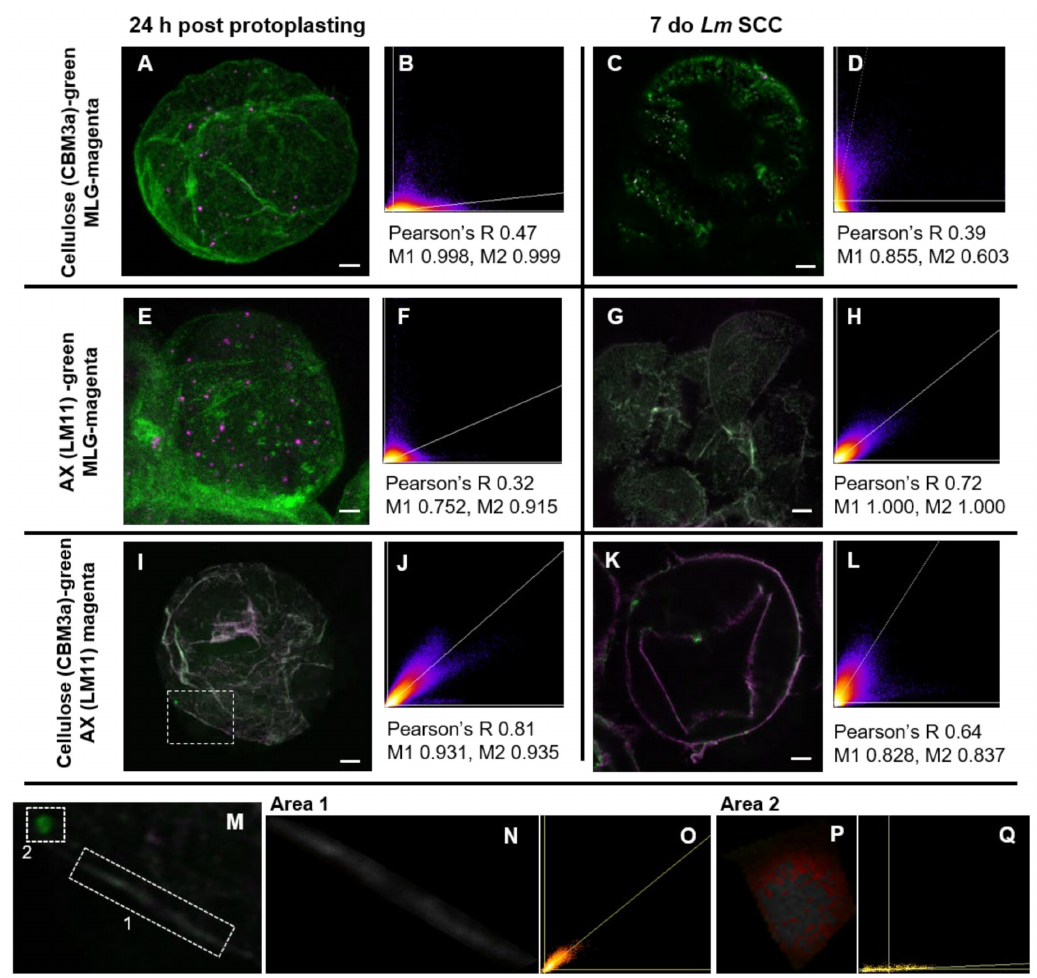
Figure 6. Colocalization of polysaccharides in Lolium SCC cells at 24 h post-protoplasting ( A , B , E , F , I , J ) and of 7 do cells from culture ( C , D , G , H , K , L ). Representative images showing colocalization in white/gray ( A , C , E , G , I , J ) alongside Pearson’s correlation coefficient graphs ( B , D , F , H , J , L ), Pearson’s coefficients, and Manders (M1 and M2) values. Colocalization was not observed between MLG and CBM3a at both time points ( A – D ). For MLG and LM11 at 24 h post-protoplasting ( E , F ), no colocalization was apparent, but there appeared to be colocalization in 7 do SCC. Colocalization was apparent between CBM3a and LM11, possibly decreasing in mature cell walls, indicating that crystalline cellulose and AX are closely associated in the cell wall, but this was not global ( M – Q ). When CBM3a and LM11 labeled features were investigated at a higher magnification ( M – O ; region from I ), some cell wall features showed high levels of colocalization ( N , O ; Area 1 from M ) and others exhibited no colocalization ( P , Q ; Area 2 from M ). ( N and P , colocalized pixel images and O and Q , Pearson’s correlation coefficient graphs of N and P , respectively). Scale bars = 5 µ